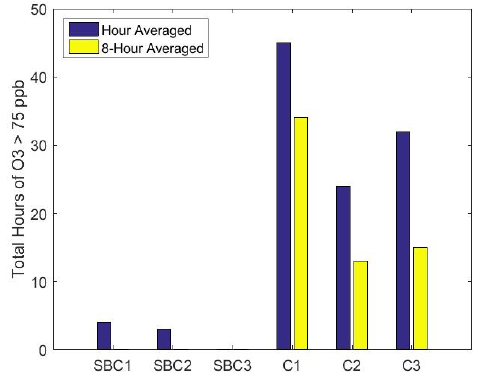
Figure 6. Total hours of ozone measurements greater than 75 ppb during deployment for 1-h and 8-h averaged data.